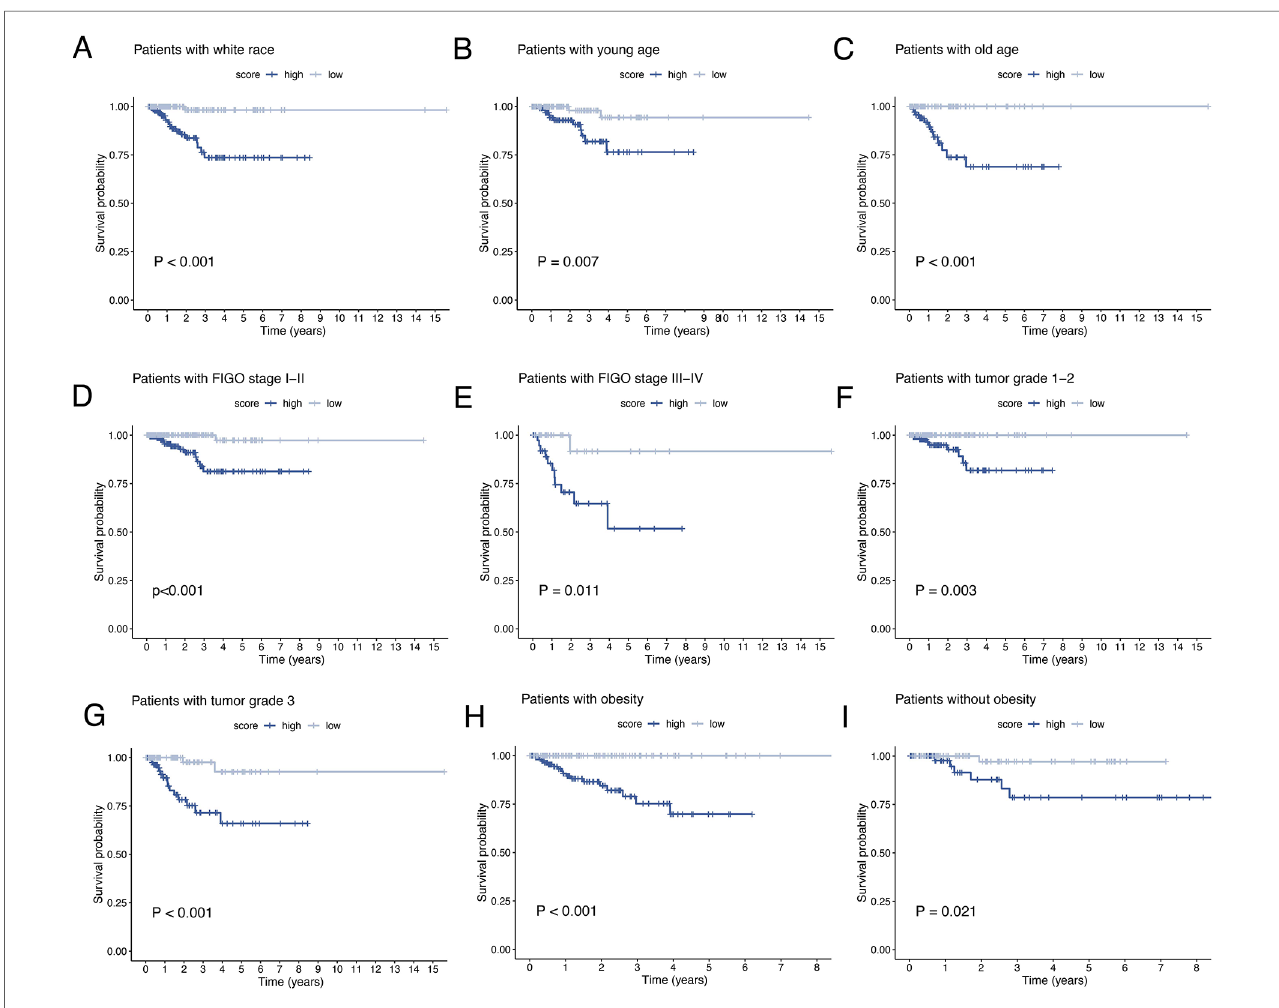
FIGURE 6 Subgroup analysis of EEC patients. Kaplan – Meier curves of patients with white race ( A ), age<65 ( B ), age ≥ 65 ( C ), FIGO stage I – II ( D ), FIGO stage III – IV ( E ), tumor grade 1 – 2 ( F ), tumor grade 3 ( G ), BMI ≥ 30 ( H ), BMI<30 ( I ). EEC, endometrioid endometrial cancer. FIGO, the International Federation of Gynecology and Obstetrics. BMI, body mass